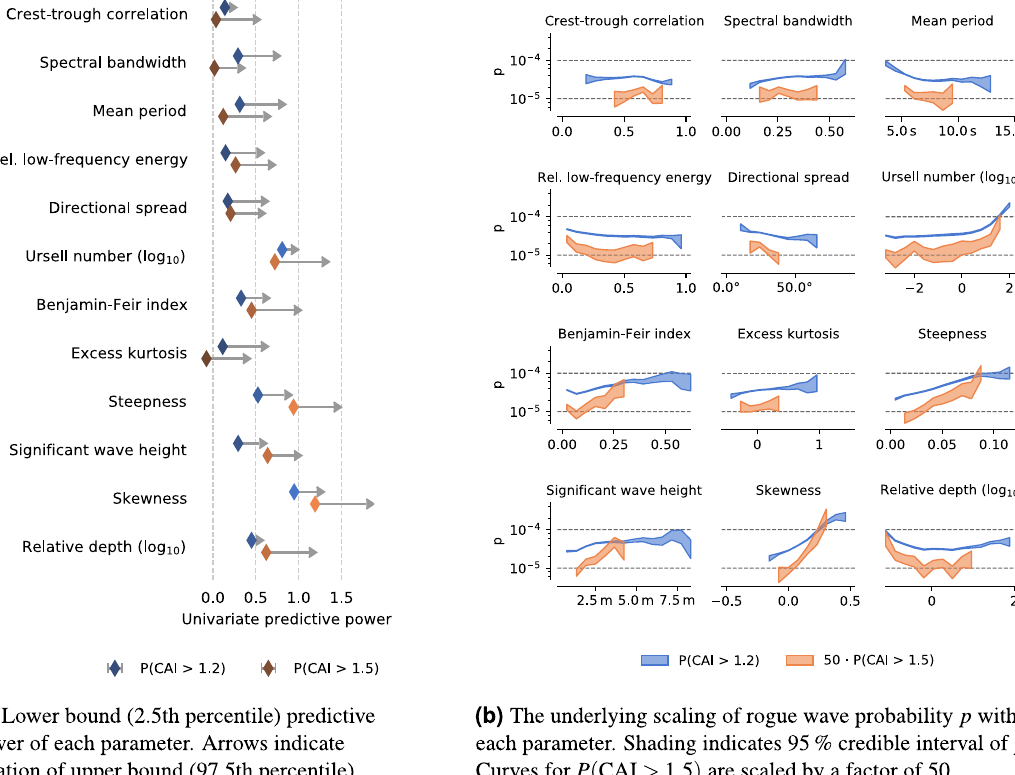
Figure 5. For rogue crests, skewness, steepness, and Ursell number are the most informative parameters. Plots are identical to Fig. 1, except that they refer to crest instead of wave